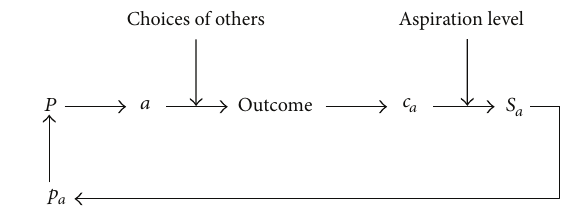
Figure 3: The learning process of decision 𝑎